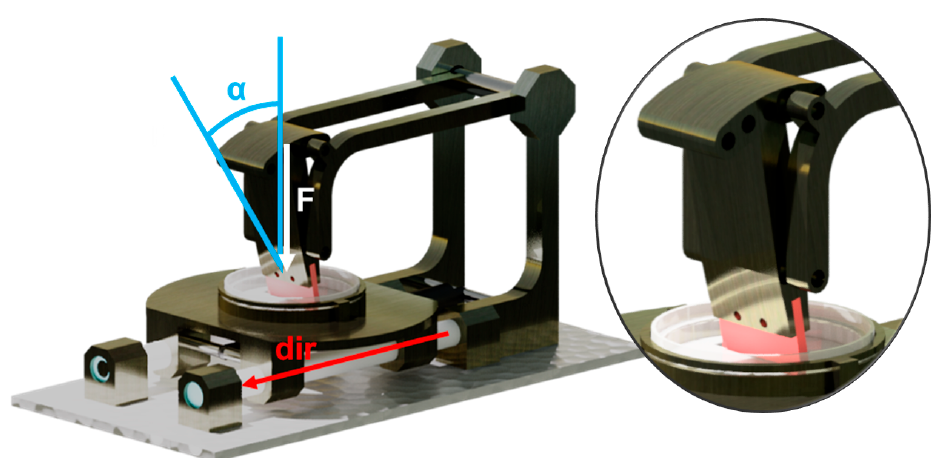
Figure 2. 3D model of the constructed apparatus consisting of two main components: while the sample translation system (front) ensures track accuracy, the actual scratching system (back/top) enables different angles and forces for the scratching blade (depicted in red). The parameters under investigation are highlighted.